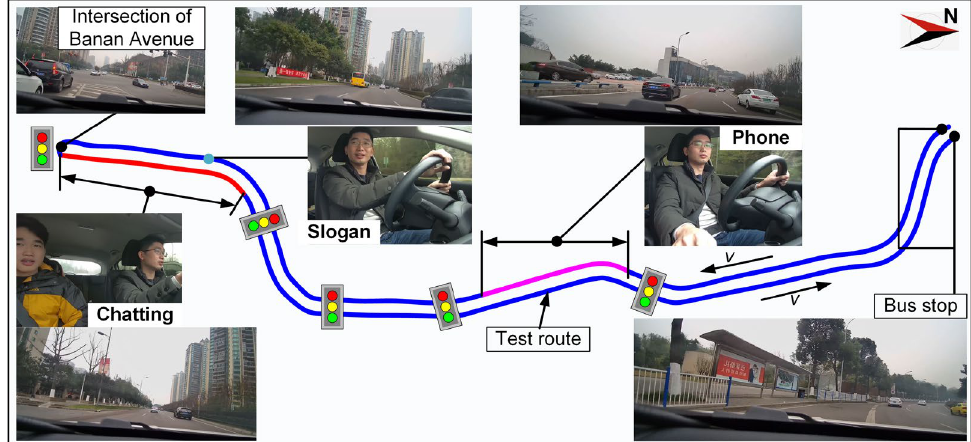
Figure 2. Test route and distracting